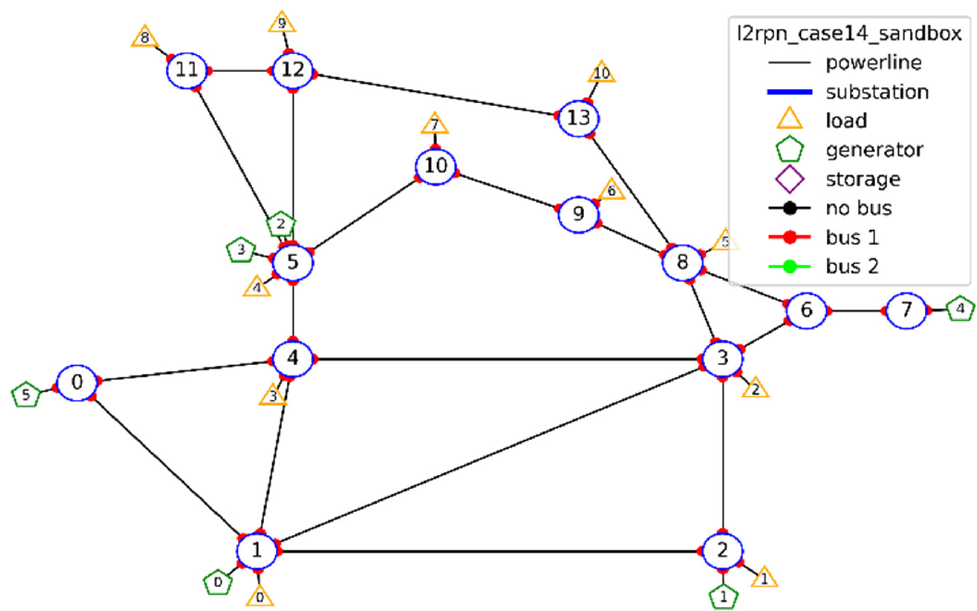
Figure 1. The adopted IEEE 14 bus test system.